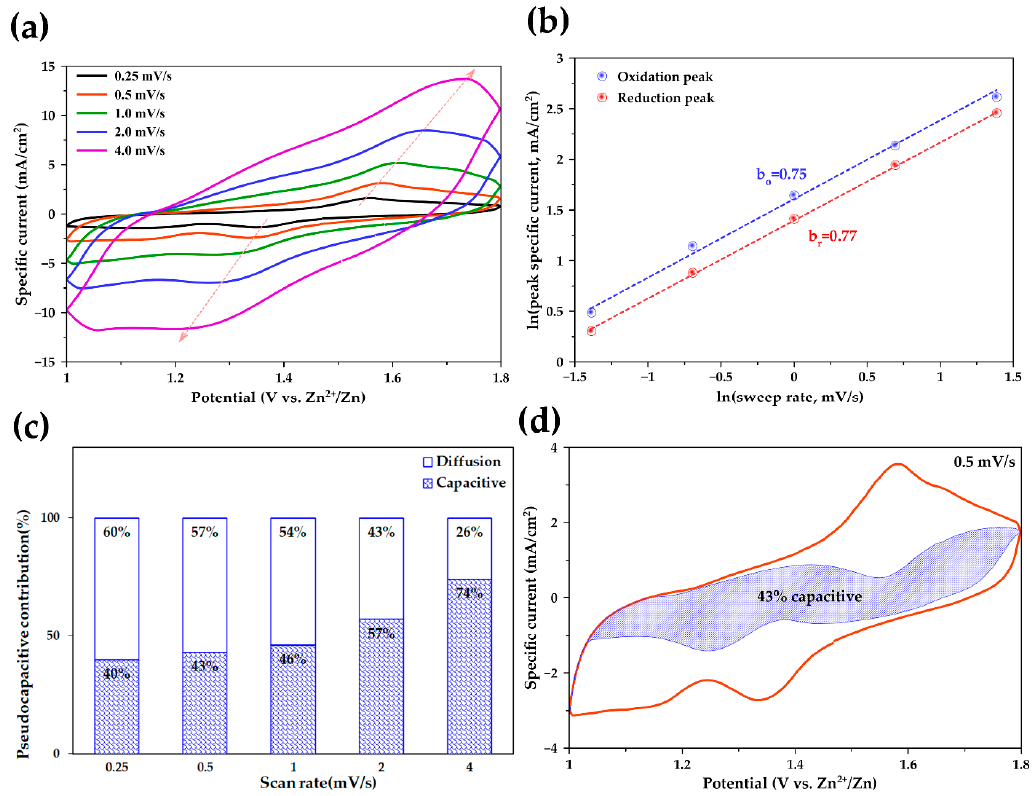
Figure 6. Electrochemical behavior: ( a ) Cyclic voltammograms of MN-CNT7525 cycling at different scan rates; ( b ) Analysis of b -value for oxidation and reduction peaks; ( c ) Capacitive contribution ratio of MN-CNT7525 electrode at different scan rates and ( d ) Capacitive contribution at a scan rate of 0.5 mV s − 1 .